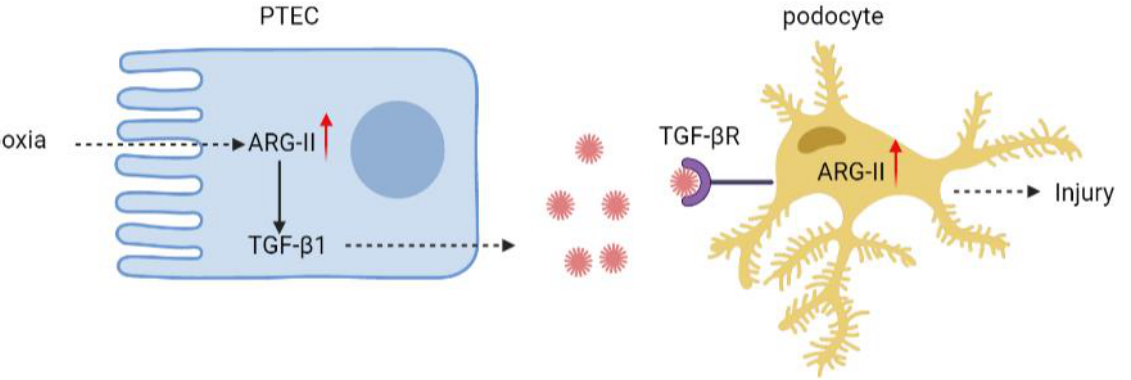
Figure 6. Schematic summary of the current study. Hypoxia increases Arg-II levels leading to enhanced TGF- β 1 production and release from PTEC. The paracrine released TGF- β 1 from PTECs activates its receptor on podocytes to increase Arg-II, leading to podocyte injury.